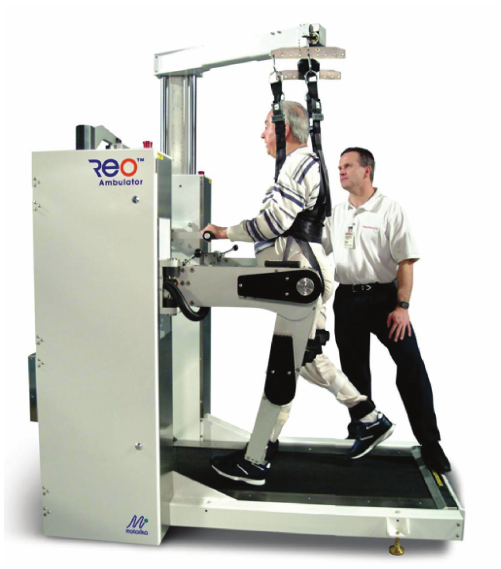
Figure 4: ReoAmbulator robotic system (picture courtesy of Motorika